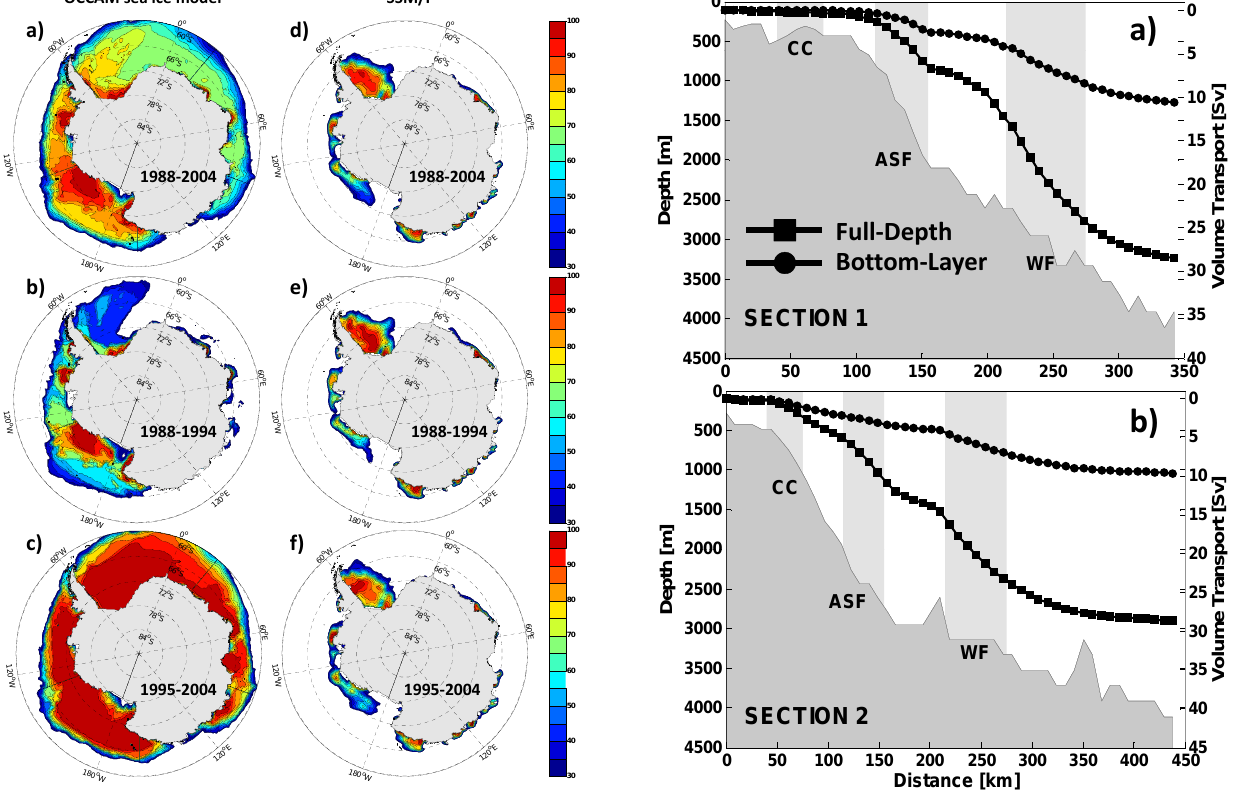
Fig. 16. Mean OCCAM model full-depth (square) and bottom-layer (circle) cumulative volume transport for (a) section 1 and (b) sec- tion 2 in the northwestern Weddell Sea. The grey rectangles indicat- ing the zone of the Antarctic Coastal Current (CC), Antarctic Slope Front (ASF) and Weddell Front (WF) as presented by Thompson and Heywood